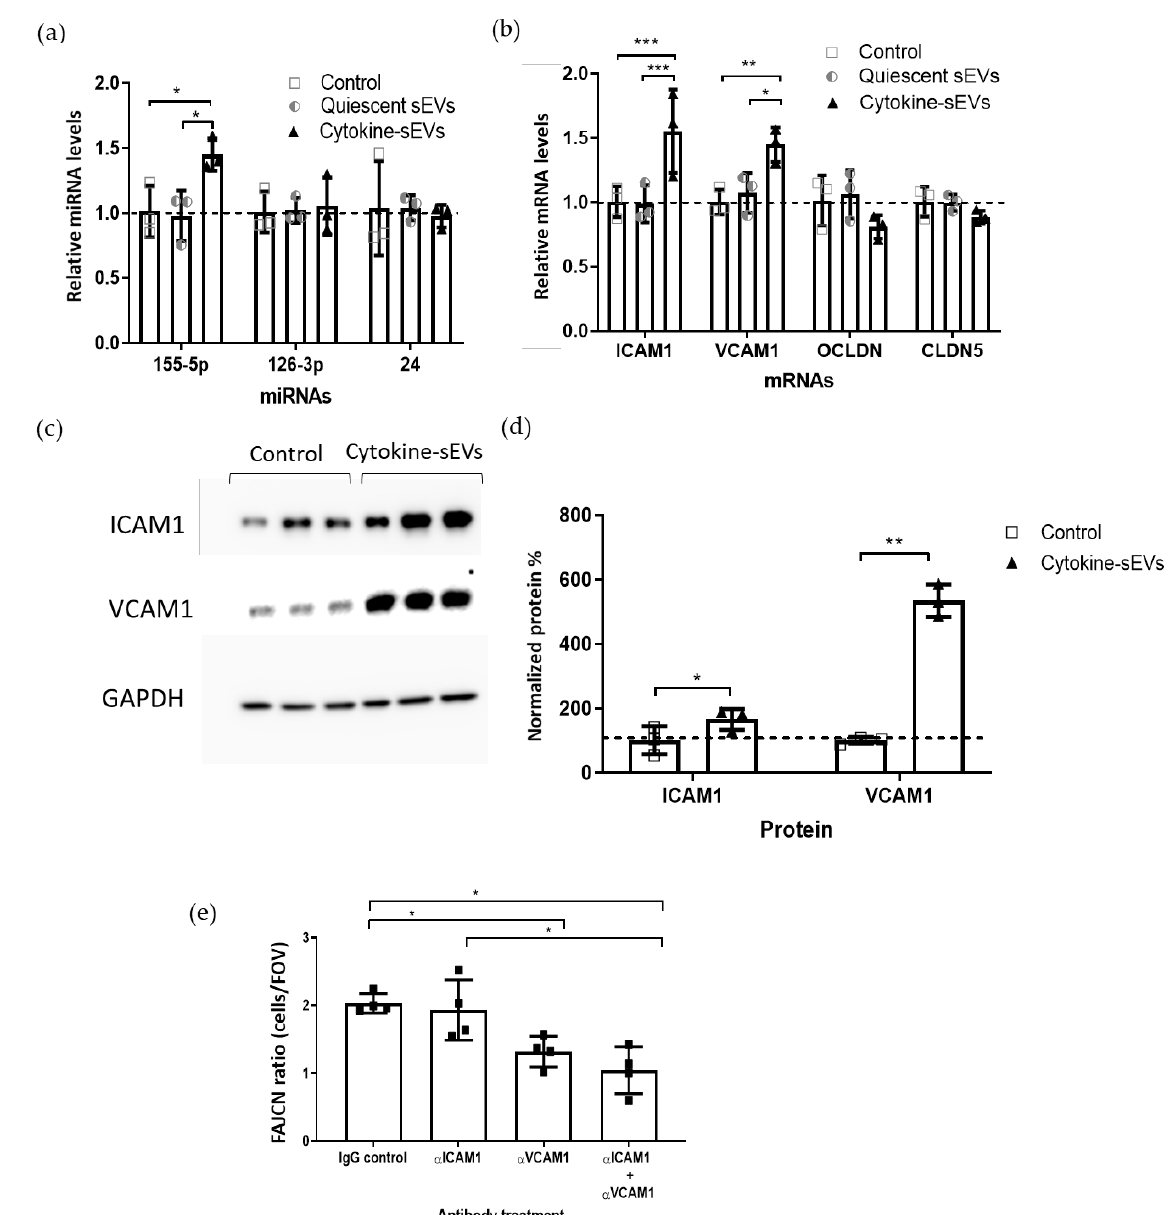
Figure 6. Cytokine-sEVs induce a proinflammatory profile in recipient hCMEC/D3 cells. ( a ) Relative levels of miRNA-155- 5p , miRNA-126-3p and miRNA-24 in hCMEC/D3 cells after treatment with cytokine- or quiescent sEVs. ( b ) Relative levels of ICAM1, VCAM1, occludin ( OCLDN ) and claudin-5 ( CLDN5 ) on hCMEC/D3 cells treated with cytokine- or quiescent sEVs for 24 h. ( c , d ) Immunoblot and quantification of cytokine-sEV-treated or untreated (control) hCMEC/D3 cells for ICAM1 and VCAM1. ( e ) Effect of blocking of ICAM and VCAM alone and in combination with the adhesion of Jurkat T cells to untreated or cytokine-sEV-treated hCMEC/D3 cells. Data is shown as the mean ± SEM, n = 3 ( a , b , d ) and n = 4 ( e ). The means were compared by two-way ANOVA followed by Tukey´s comparison test ( a , b ) or paired two-tailed t -test ( d ), * p < 0.05, ** p < 0.01 and *** p < 0.001 in comparison to untreated cell levels ( a , b , d ) or to the IgG control ( e ).